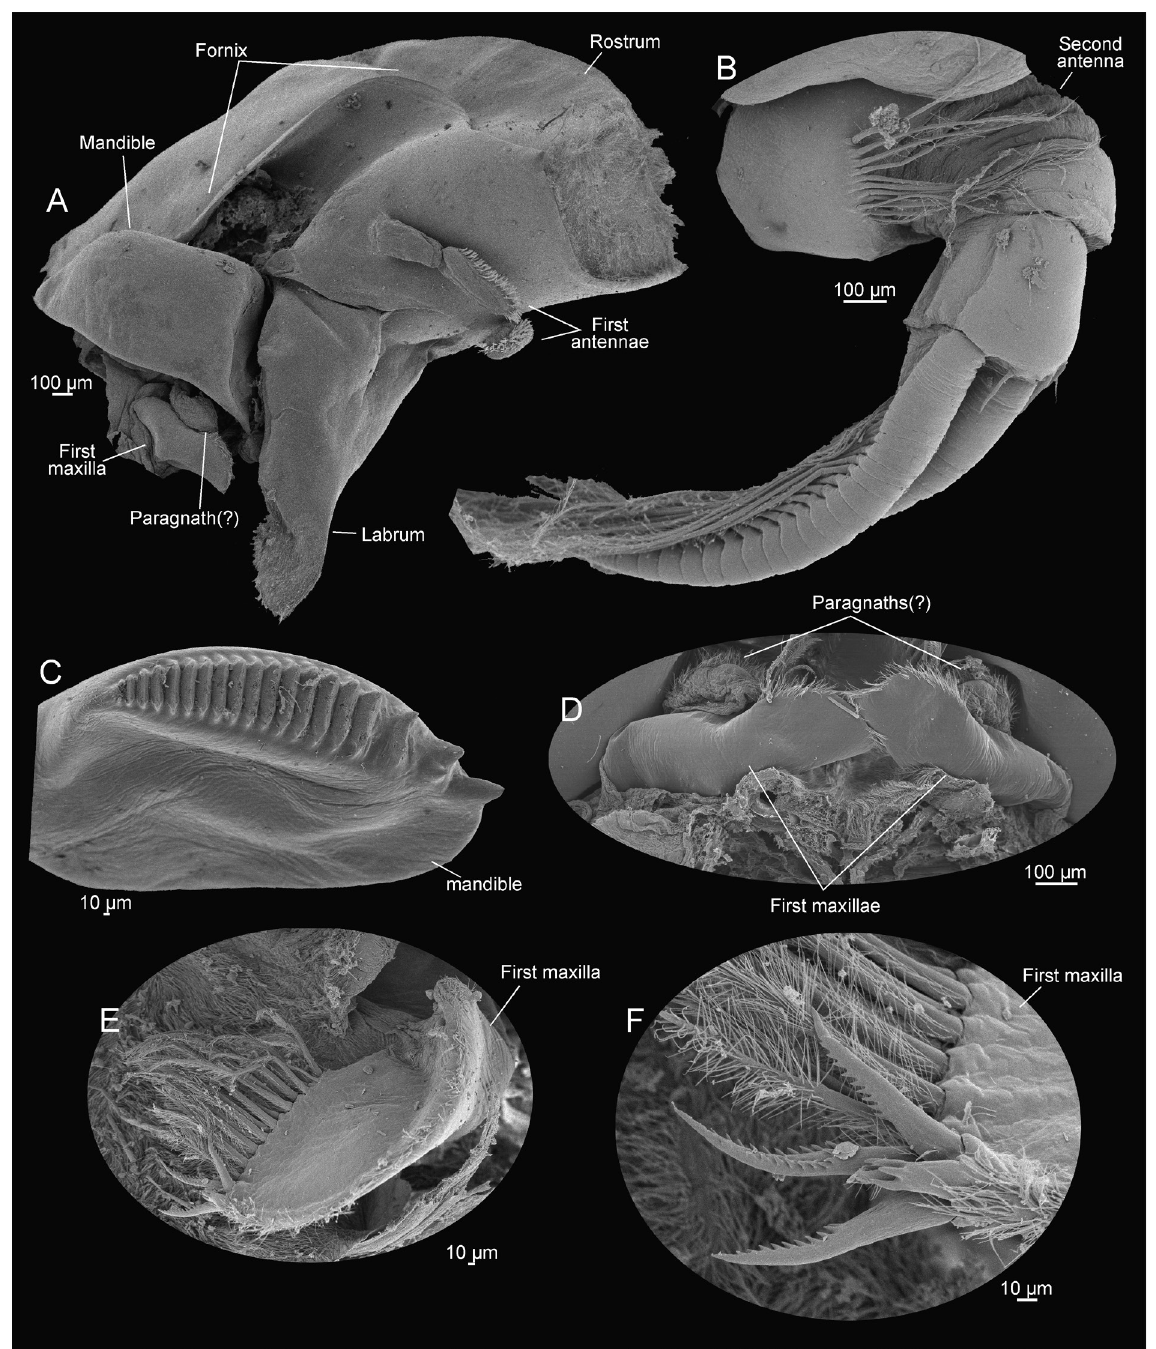
Fig. 5. Lynceus insularis sp. nov., scanning electron microscopy (paratypes, ZMUC-CRU-4787; A, ♂; B–F, ♀). A . Head, rostrum and labrum of right side. B . Second antenna, left side. C . Gnathal edge of mandible, left side. D . First maxillae from posterior. E . First maxilla, left side, from ventral. F . Posteriomedial spine bearing corner of first